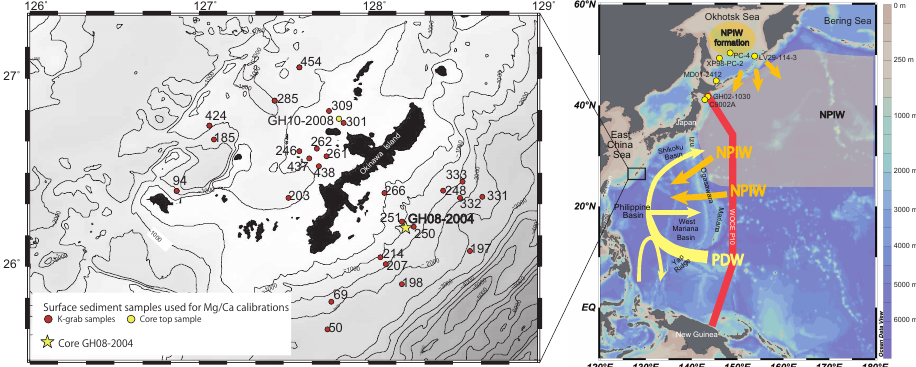
Figure 1. Map showing the locations of surface sediment samples and cores discussed in this study. The orange and yellow arrows indicate the flow of water at 500 and 1500m water depth, respectively (Kaneko et al., 2001). The red line indicates WOCE Section P10. NPIW: North Pacific Intermediate Water; PDW: Pacific Deep